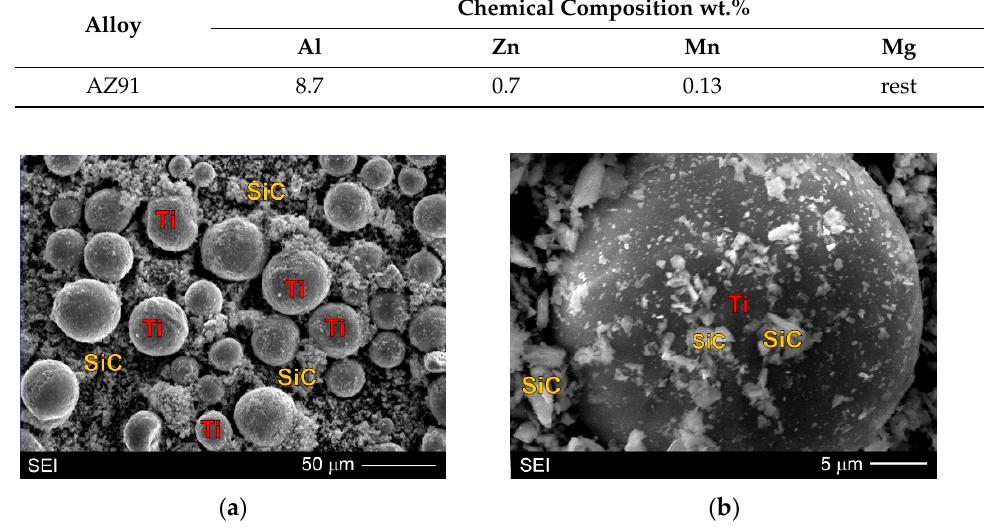
Figure 3. SEM micrographs of used Ti and SiC particle mixture: ( a,b ) Images taken at different magnification.